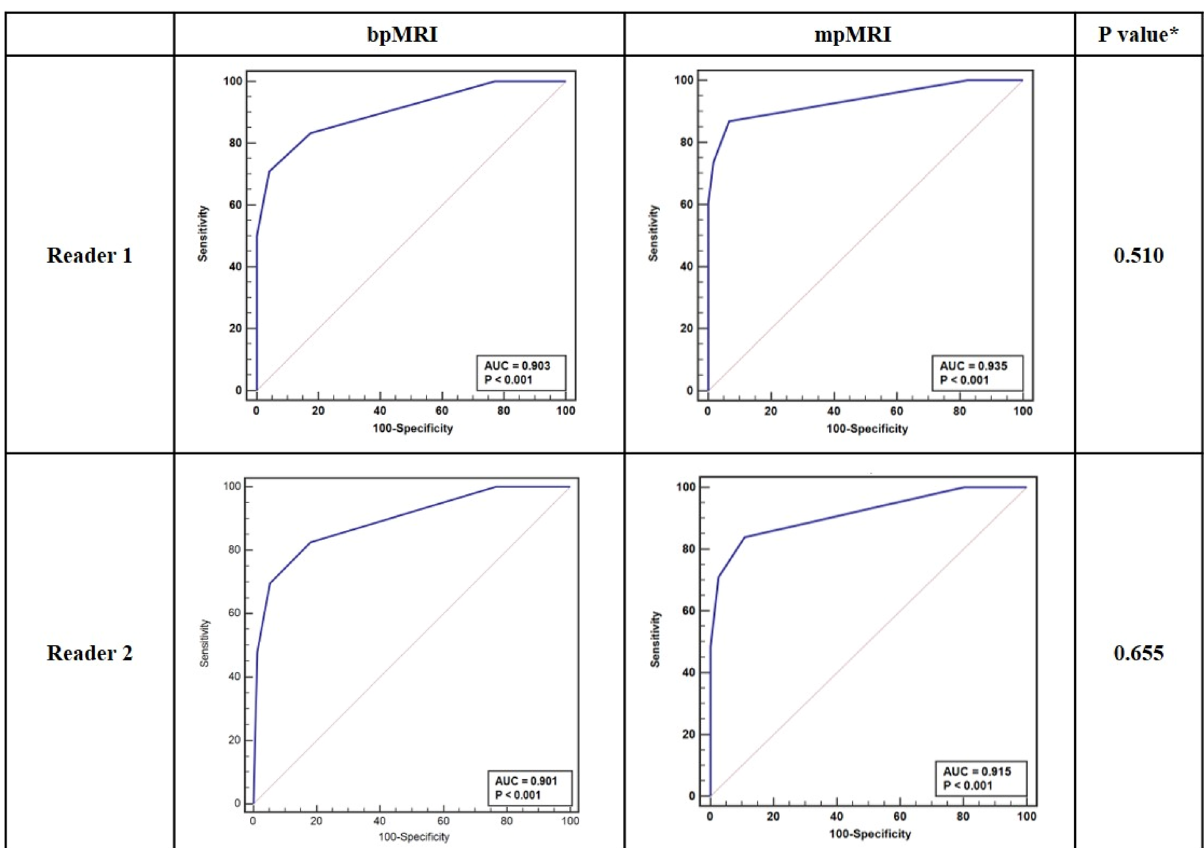
Figure 3. Comparison of ROC curve and inter-reader agreement between bpMRI and mpMRI. A VI-RADS score ≥ 3 was assumed to define MIBC. Asterisk: comparison of two independent ROC curves between bpMRI and mpMRI was performed using Delong’s test. AUC area under the curve, bpMRI biparametric magnetic resonance imaging, mpMRI multiparametric magnetic resonance imaging, ROC receiver operating